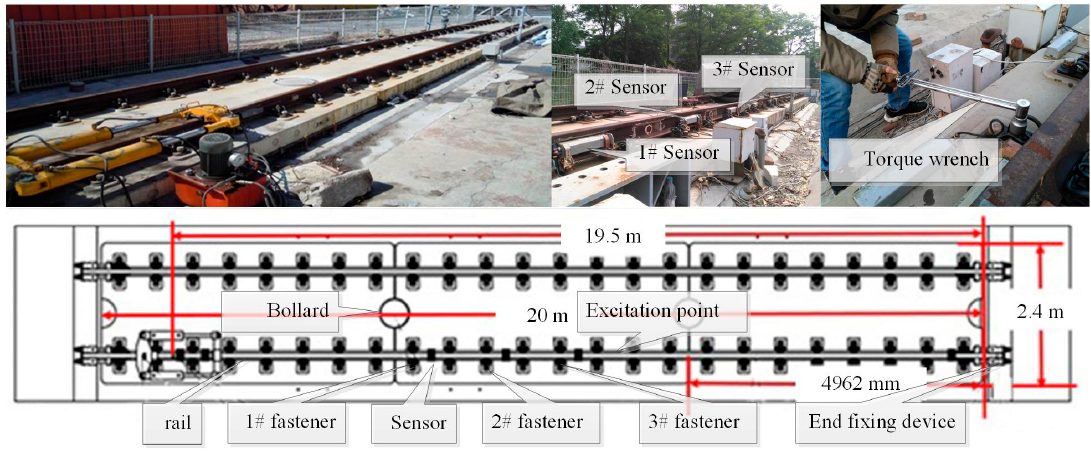
Figure 4. The scene of the experimental platform.